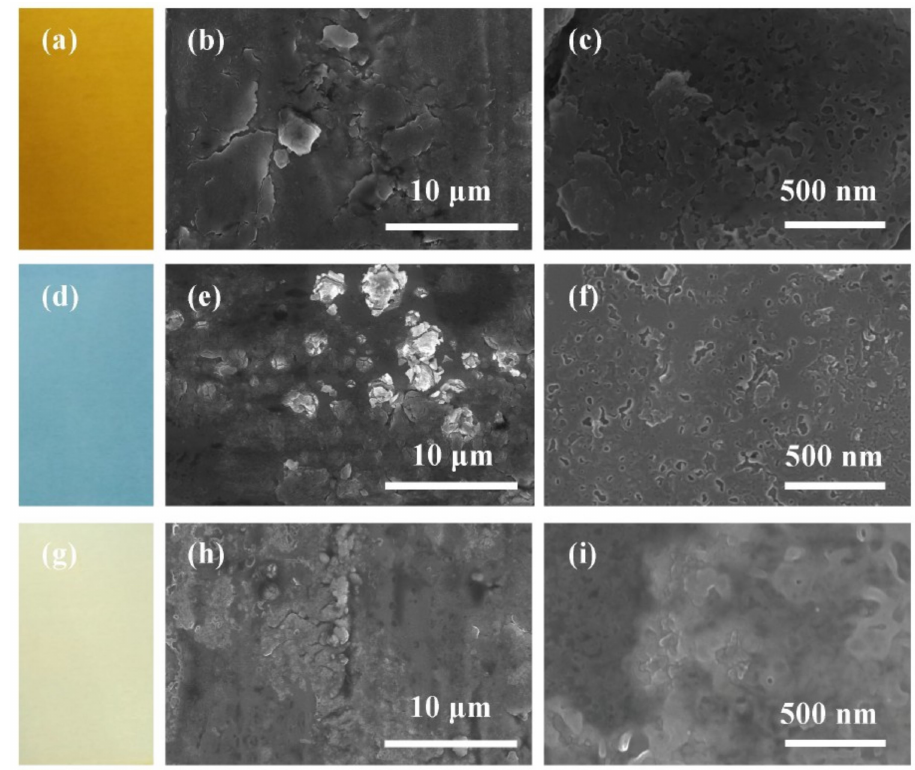
Figure 1. Surface colors and scanning electron microscopy (SEM) images of the surface of the oxide films formed at different voltages: ( a–c ) Ti 10 ; ( d–f ) Ti 30 ; ( g–i ) Ti 50